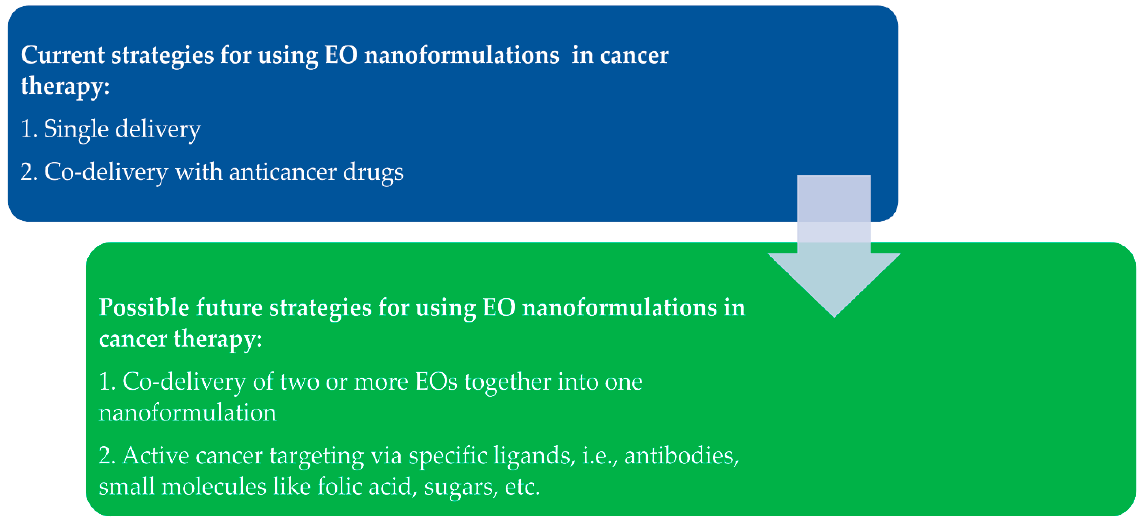
Figure 11. Schematic representation of the current and potential future research strategies for nanoformulation delivery systems using EOs.